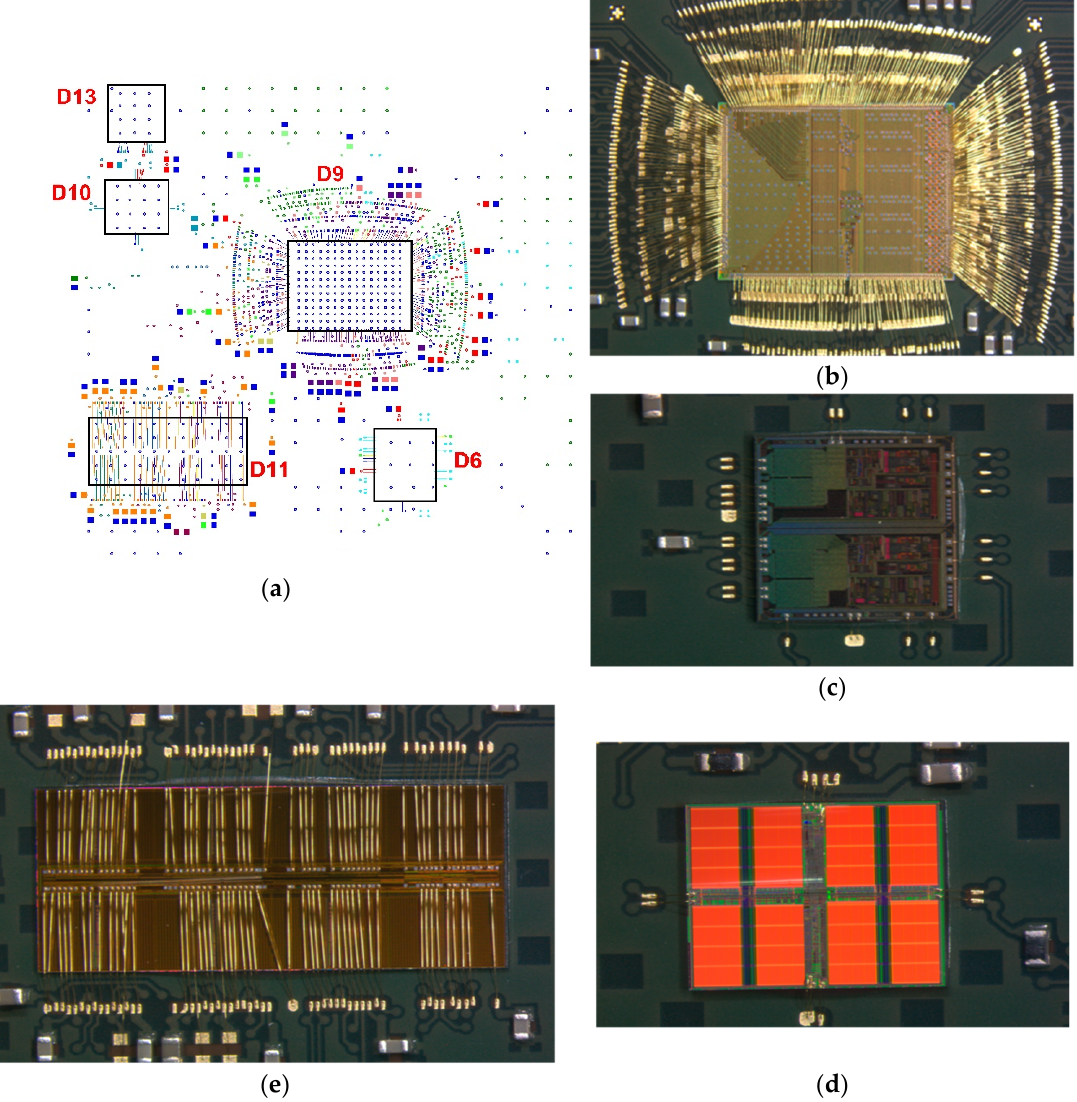
Figure 2. SiP internal die microphotographs. ( a ) SIP internal layout; ( b ) D9-Zynq die local photo; ( c ) D6-1553B driver die local photo; ( d ) D10-Flash die local photo; ( e ) D11-DDR3 die local photo.